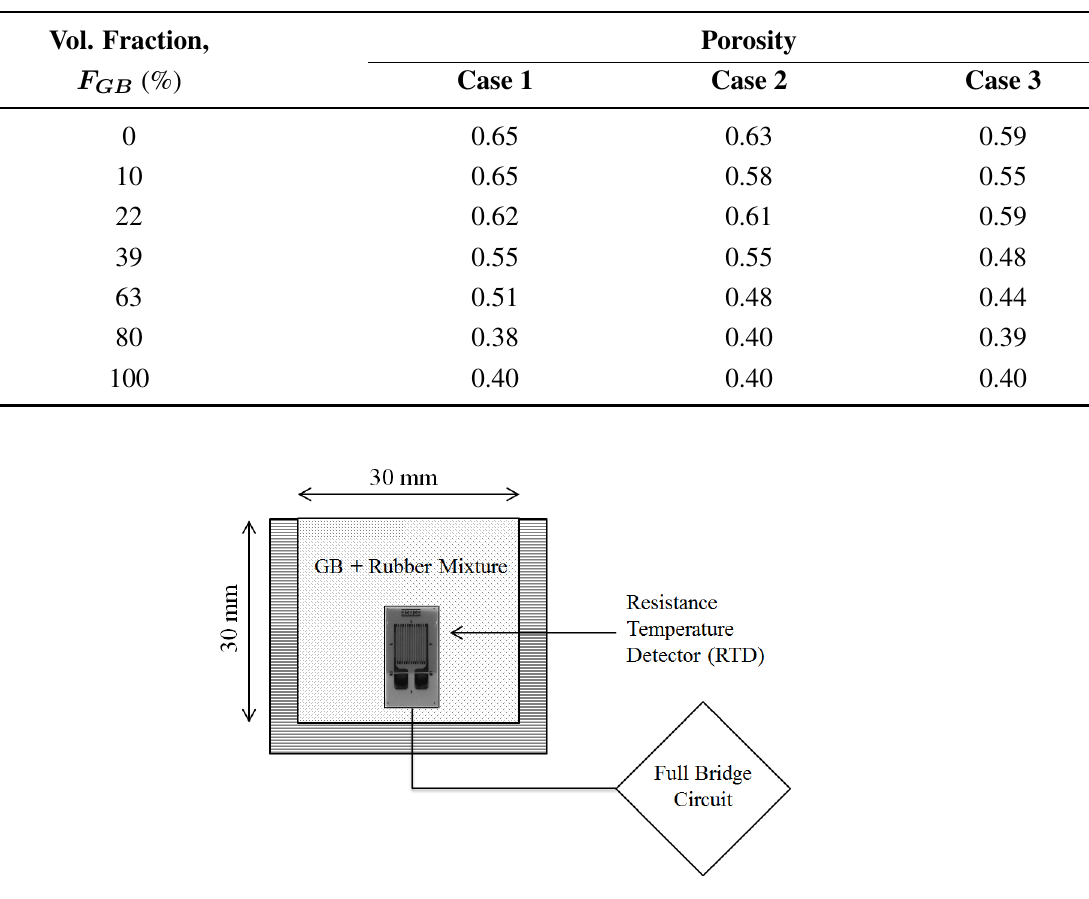
Table 2. Volumetric fraction and porosity of glass bead-rubber mixture.